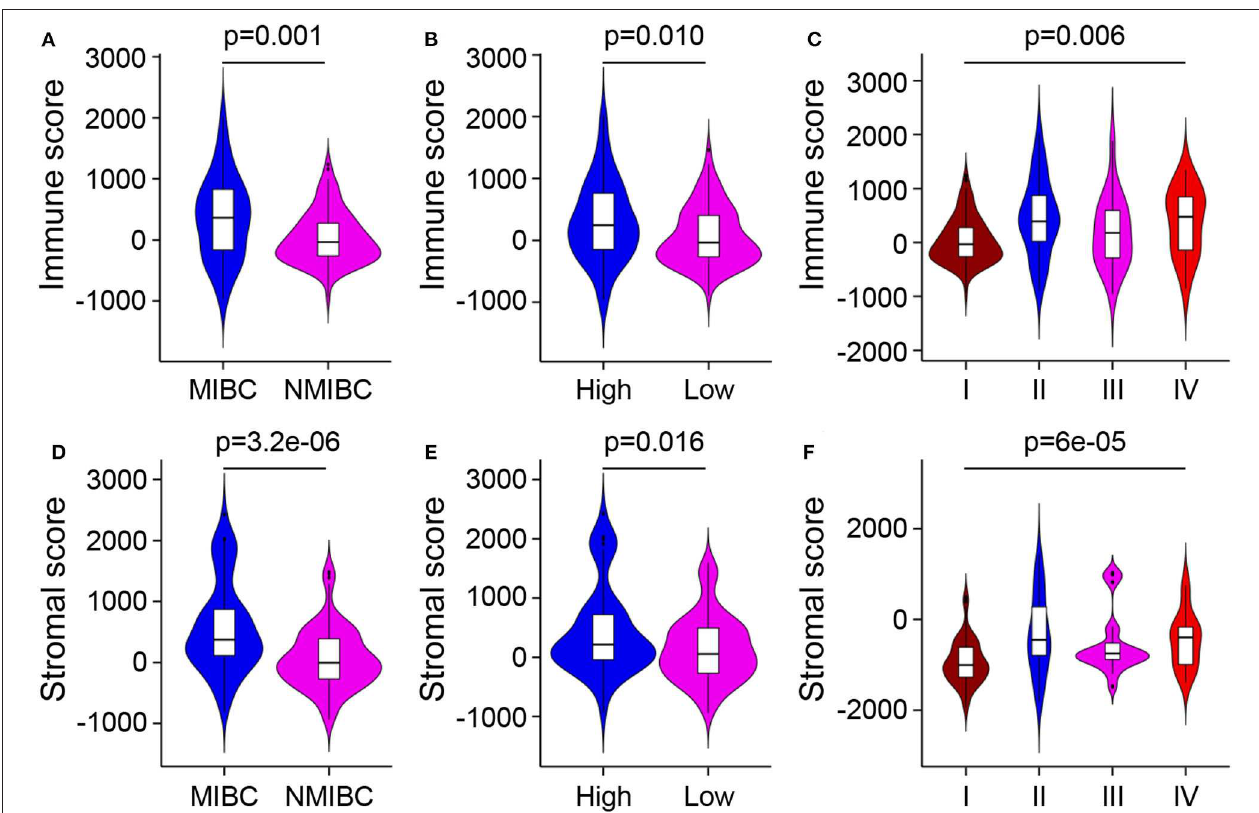
FIGURE 1 | Relationship between immune and stromal scores and BC clinical characteristics. (A–C) Distributions of immune scores among different BC invasions, differentiation grades, and stages. (D–F) Distributions of stromal scores among different BC invasions, differentiation grades, and stages. MIBC, muscle-invasive bladder cancer; NMIBC, non-muscle-invasive bladder